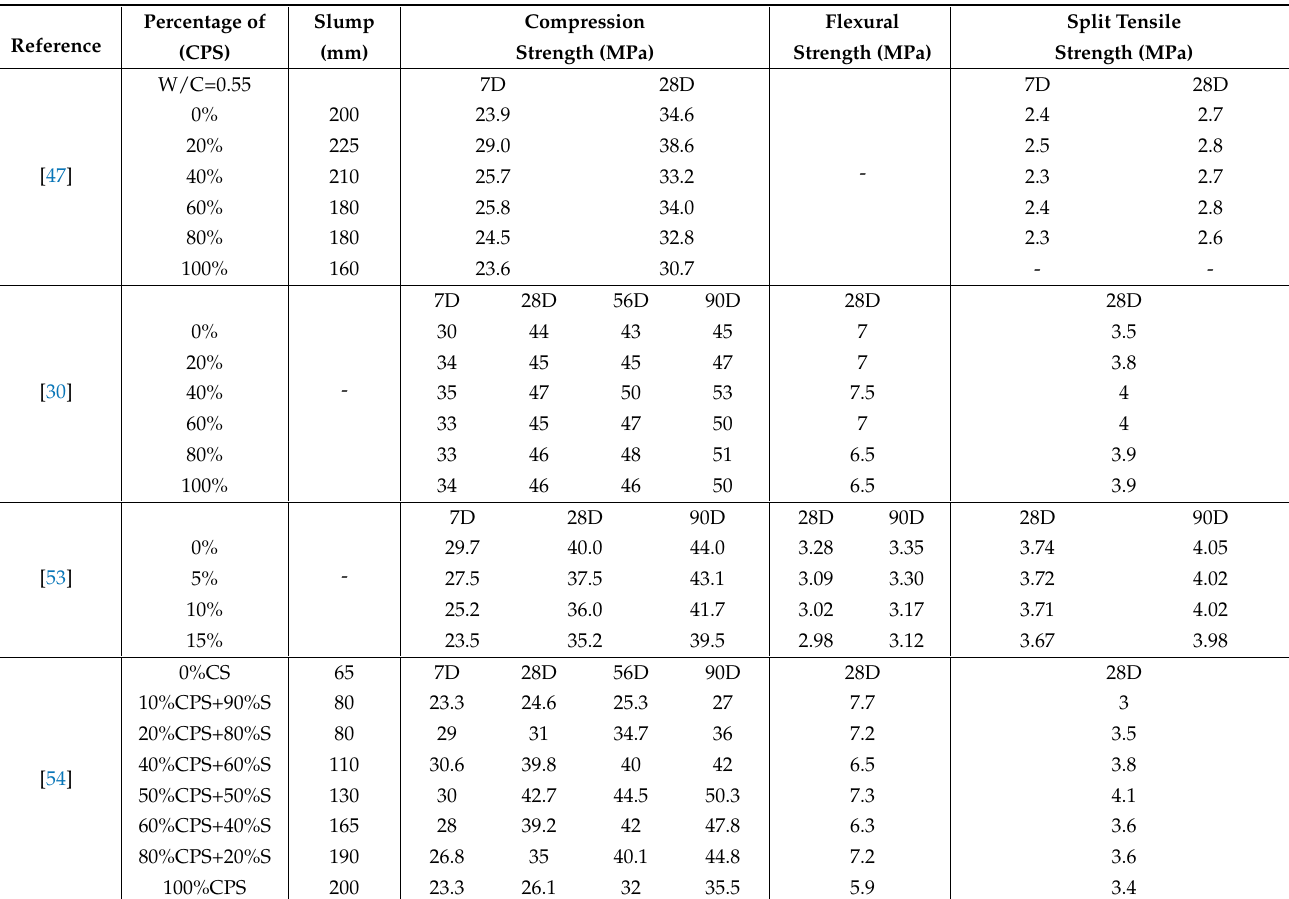
Figure 14. Correlation between compressive and flexural strength: data source [45]. Table 3. Summary of slump and mechanical strength of concrete with copper slag